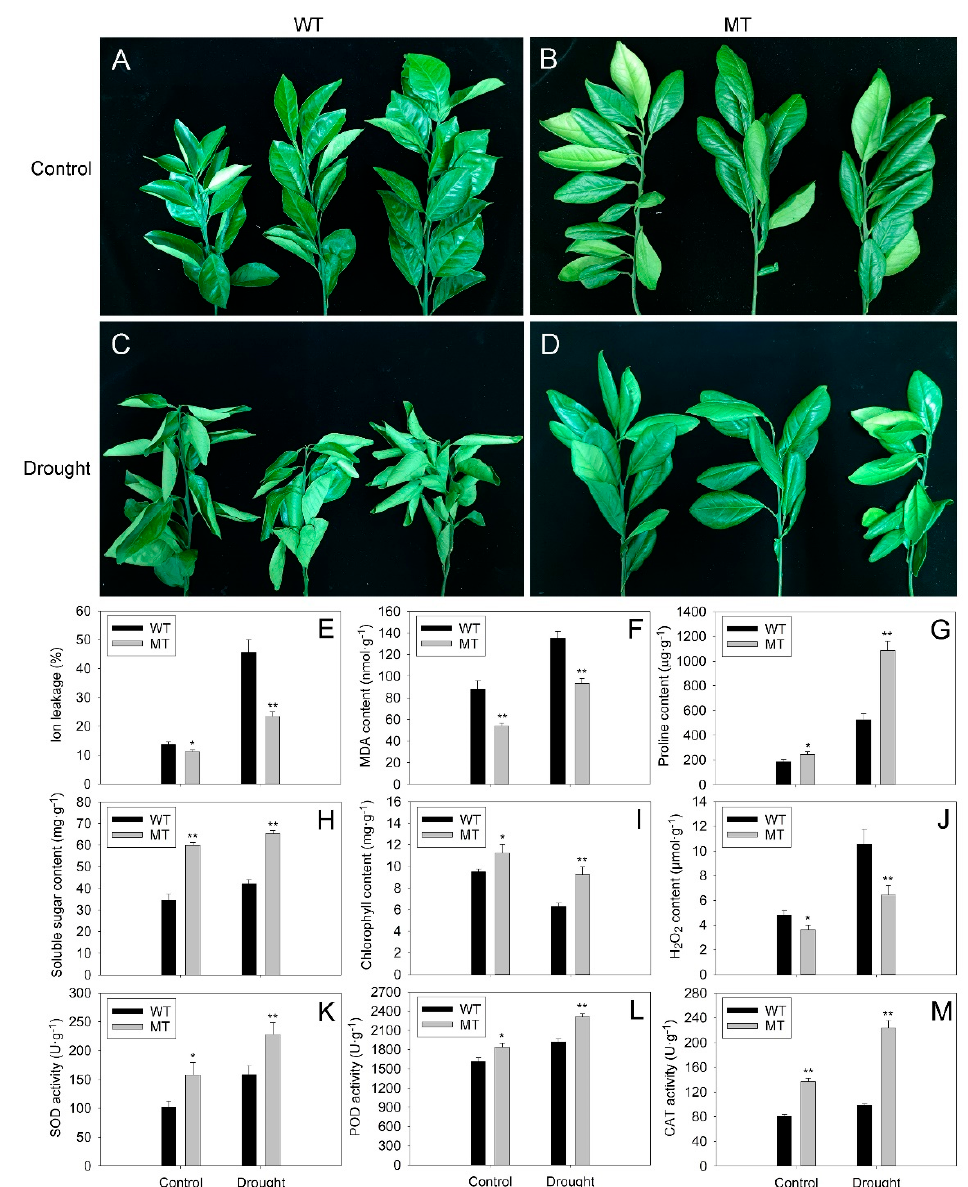
Figure 4. The morphological and physiological analyses of WT and MT plants under control (well − watered) and drought conditions (without watering for 21 days). ( A – D ) Phenotype of WT and MT seedings under control and drought conditions. The leaves of WT and MT leaves were collected to measure the ( E ) ion leakage, the contents of ( F ) MDA, ( G ) proline, ( H ) soluble sugar, ( I ) chlorophyll, ( J ) H 2 O 2 and the activities of ( K ) SOD, ( L ) POD, ( M ) CAT. Vertical bars represent standard deviations of the means ( n = 3). Significant differences between WT and MT leaves at the p < 0.05 and p < 0.01 levels were indicated by * and **, respectively, according to Student’s t − test. Photosynthetic analysis showed that the net photosynthetic rate (Pn), stomatal con-